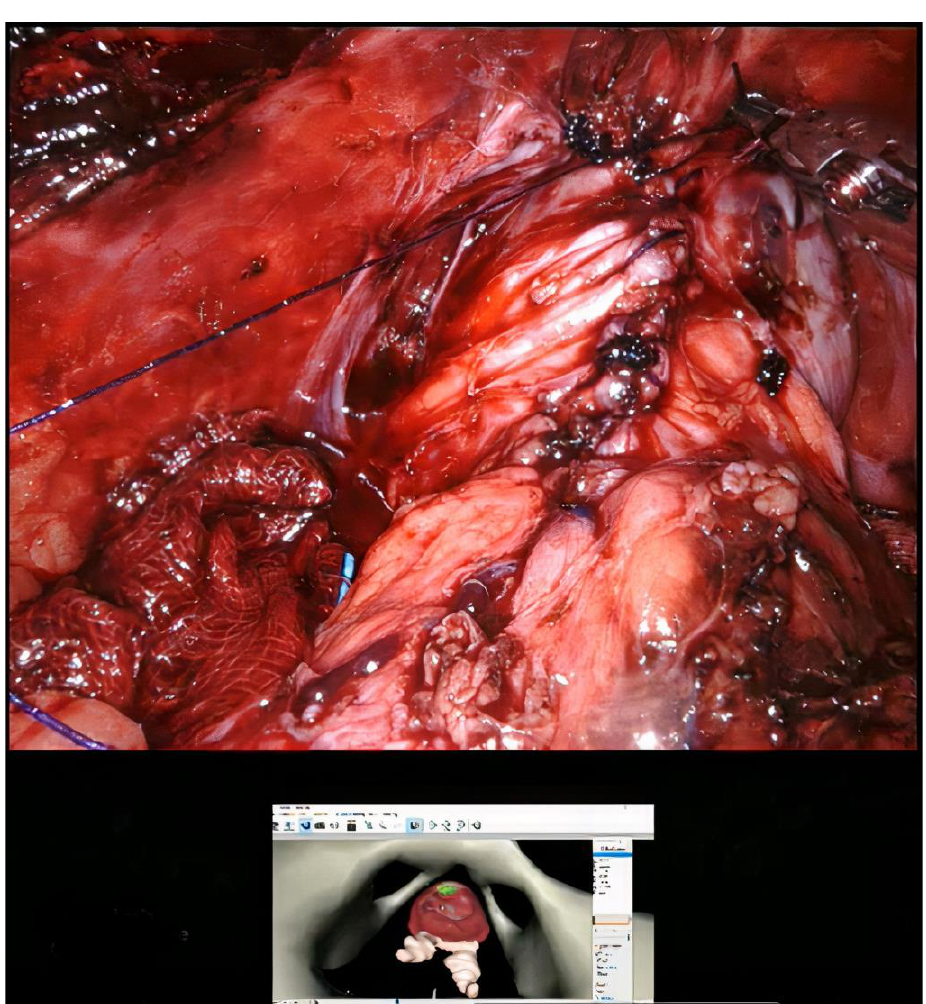
Figure 6. After intraoperative frozen review, the excised site was closed with watertight suture.